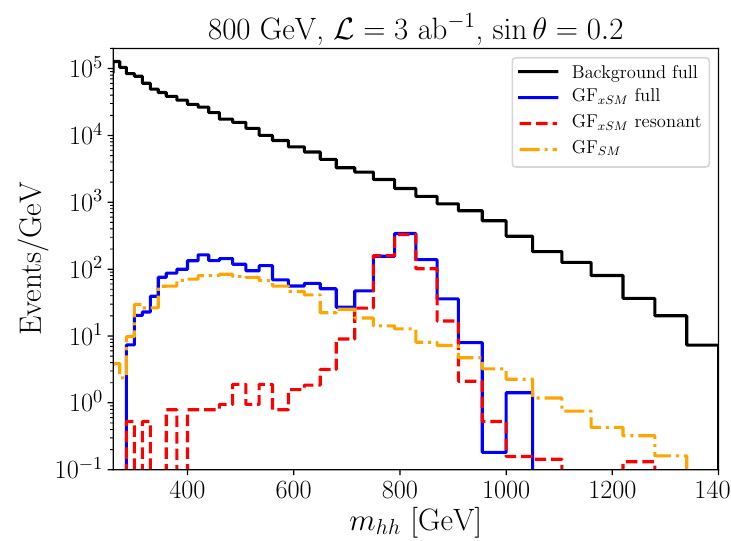
Figure 4 . m hh distribution for the GF components: SM (yellow), xSM resonant (red), and xSM full that accounts for the resonant and non-resonant contributions (blue). The total background component obtained from ATLAS via a data driven approach is also shown (black) [17]. The signal sample is simulated with a Heavy Higgs mass m h = 800 GeV, v s = 24 : 8 GeV, b 3 =v EW = 2 (cid:0)